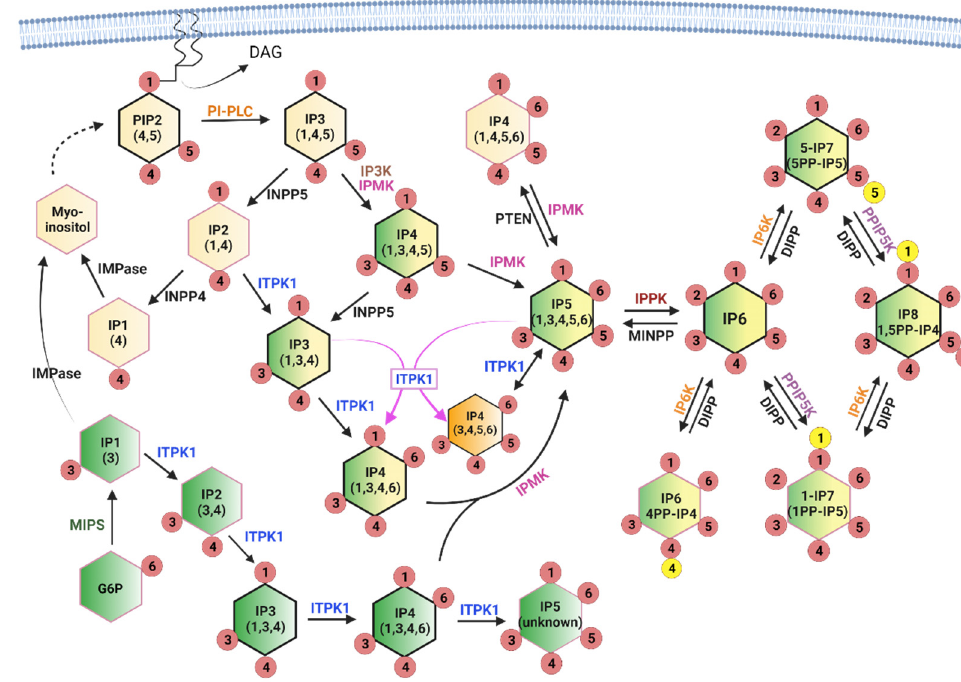
Figure 2. Biosynthesis of InsPs and PP-InsPs in mammalian cells. Lipid-derived precursors originate from PtdIns(4,5)P2 and are shown in yellow; glucose-derived precursors originate from G6P and are shown in green. Stereoisomers that can originate from both sources are shown as dual colors. InsP4(3,4,5,6) is highlighted in orange due to its unique function as an ion channel regulator (see text). Bold black outlines highlight the dominant synthetic pathways in humans. Forward and reverse reactions are indicated with black arrows; only the reverse reactions proposed to commonly occur are indicated. Magenta arrows indicate ITPK1 phosphotransferase reaction. The dashed arrow from myo-inositol to PIP2 refers to a multistep reaction. Kinases are color-coded to aid in visualization due to substrate promiscuity. Phosphatases are shown in black. PI-PLC: phosphatidylinositol specific phospholipase C; IP3K: inositol-trisphosphate 3-kinase; IPMK: inositol polyphosphate multikinase; ITPK1: inositol-tetrakisphosphate 1-kinase; IPPK: inositol-pentakisphosphate 2-kinase; IP6K: inositol hexakisphosphate kinase; PPIP5K: diphosphoinositol pentakisphosphate kinase; MIPS: myo-inositol 1-phosphate synthase; IMPase: inositol monophosphatase; INPP4/INPP5: inositol polyphosphate-4-phosphatase/inositol polyphosphate-5-phosphatase. Created with BioRender.com, accessed on 27 May